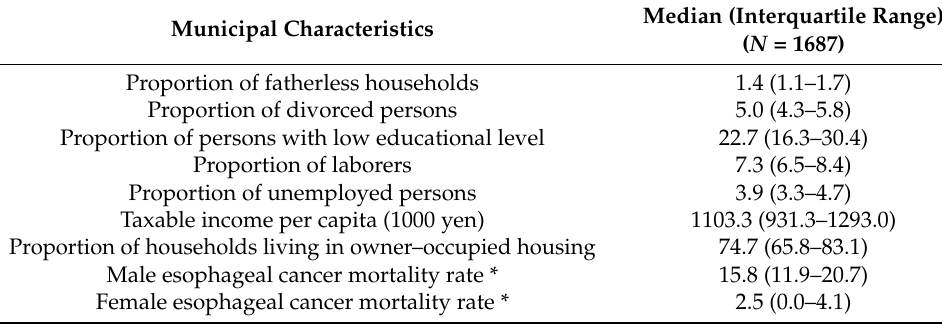
Table 2. Basic characteristics of municipalities used in the analysis.